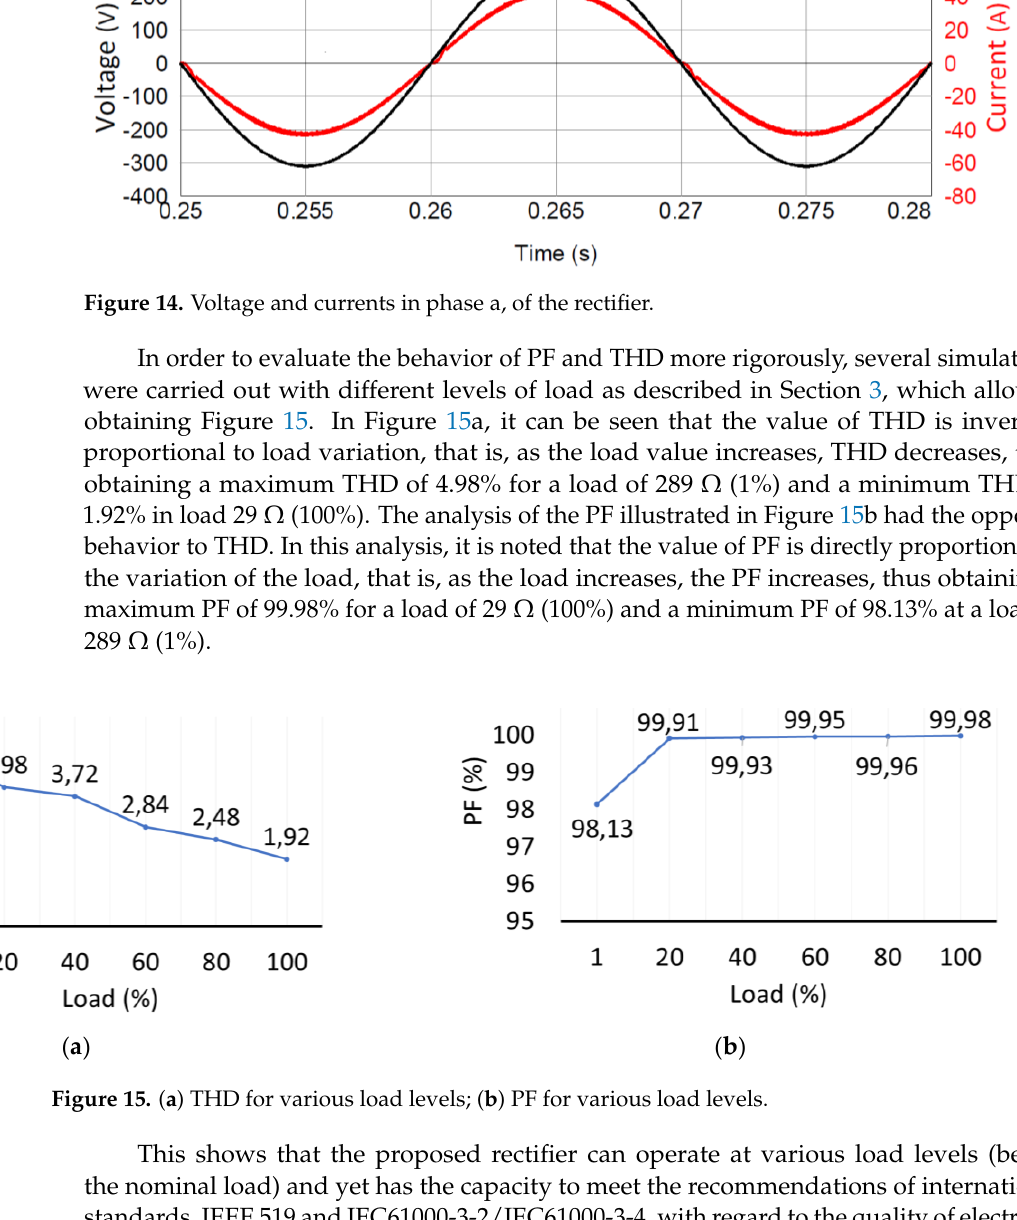
Figure 14. Voltage and currents in phase a, of the rectifier.